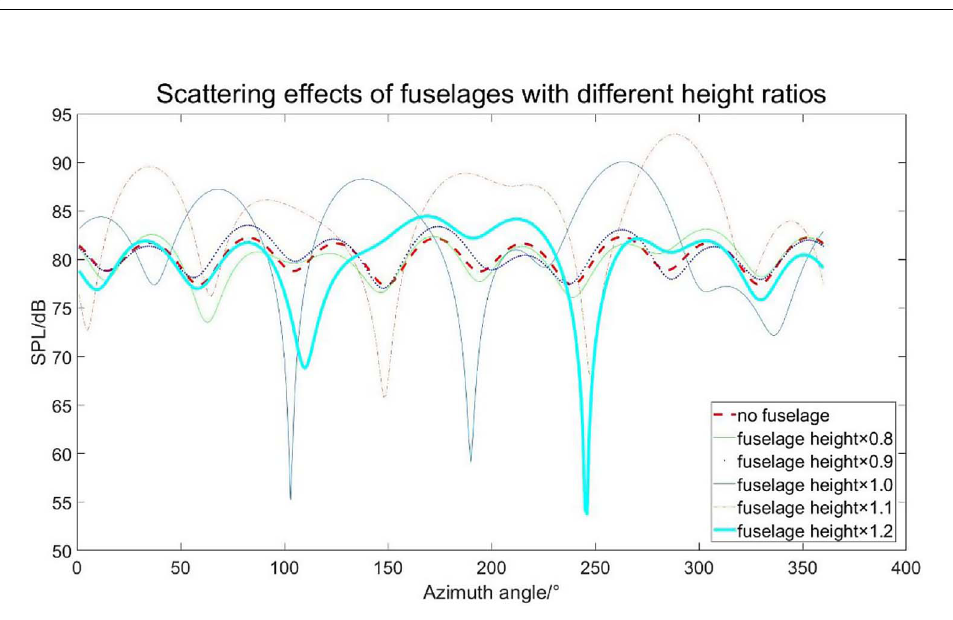
Figure 21. Scattering effect of fuselages with different height